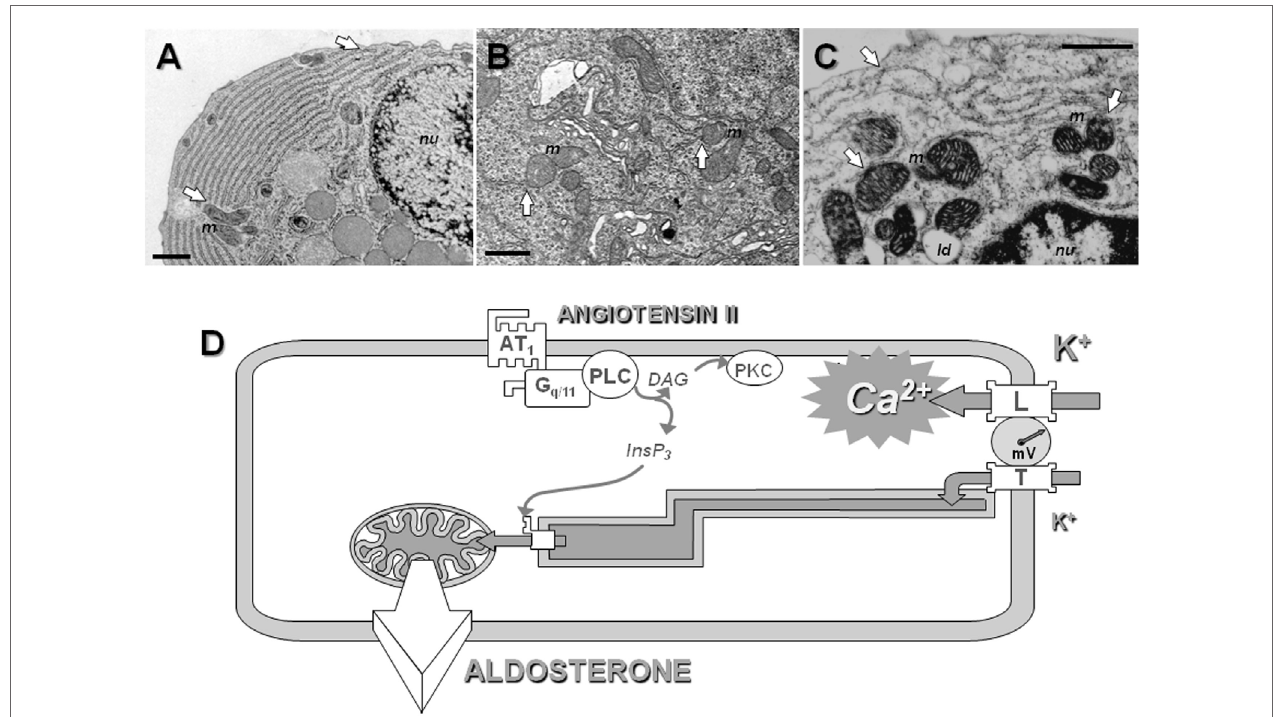
FiGURe 3 | The concept of intracellular calcium pipeline: a model for explaining the selective transport of calcium from the T channels into the mitochondria . Electron microscopy reveals the presence of close apposition in many places of the endoplasmic reticulum (ER) with the plasma membrane or the mitochondria (white arrows), within various cell types, including rat parotid cells (A) , rat spinal cord neurons (B) , or bovine adrenal glomerulosa cells (C) . Scale = 1 μ m; m indicates mitochondria, nu nucleus and ld lipid droplets. See Ref. (112) for additional information. (D) . A hypothetical model for the cellular transport of calcium into mitochondria. At the pipeline filling site, T-type calcium channels and, to a lesser extent, L-type channels are activated upon cell depolarization by potassium or angiotensin II. Several experimental data suggest that calcium entering the cell through T-type channels could be selectively pumped into the lumen of the ER, while calcium entering through L-type channels would be poured into the cytosol. At the pipeline delivery site, InsP3 receptors are maintained in proximity of the mitochondria within “quasi synaptic” structures. Calcium released upon activation of the InsP3 receptors, due to calcium overloading of the ER and/or to InsP3 production by AT 1 receptor-activated PLC, is rapidly internalized into the very negatively charged matrix, through the mitochondrial inner membrane calcium uniporter. Intramitochondrial calcium elevation then stimulates limiting steps of aldosterone biosynthesis. AT 1 , angiotensin II receptor, type 1; G q/11 , heterotrimeric G protein of the q/11 family; PLC, phospholipase C β ; PKC, protein kinase C; InsP 3 , inositol